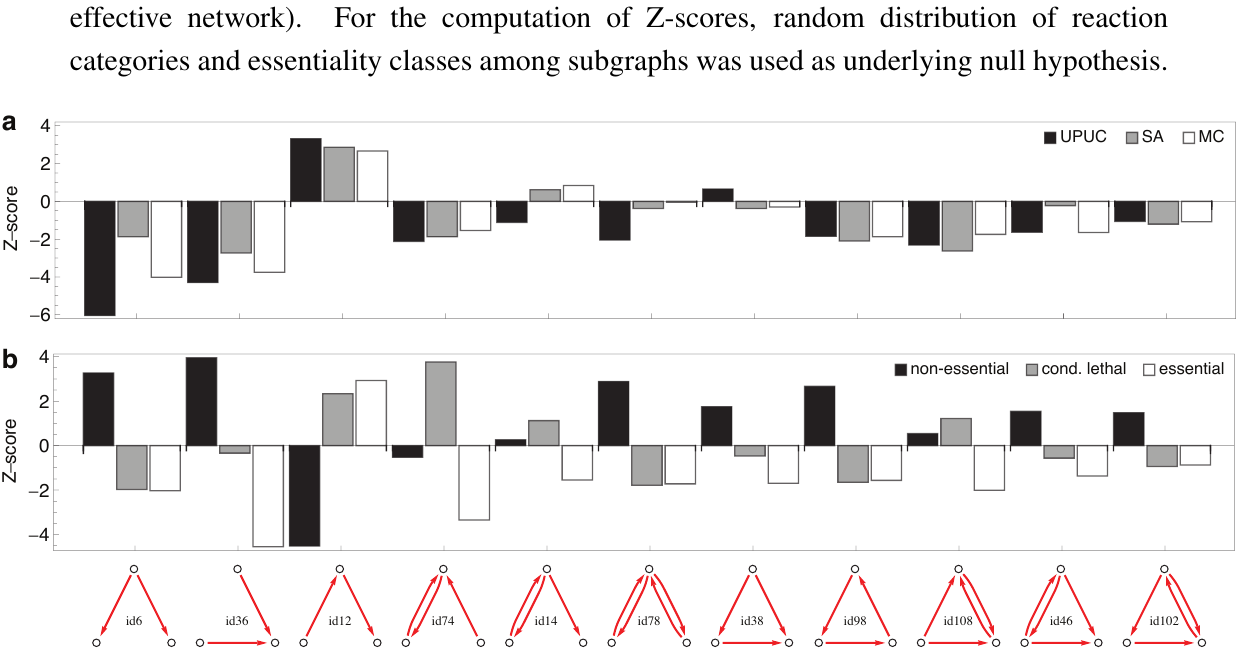
Figure 6. Enrichment on three-node subgraphs. The statistical over- and under- representation of ( a ) reaction categories and ( b ) essentiality classes on all occurring three-node subgraphs (two motifs have been omitted as they were not detected in any effective network). For the computation of Z-scores, random distribution of